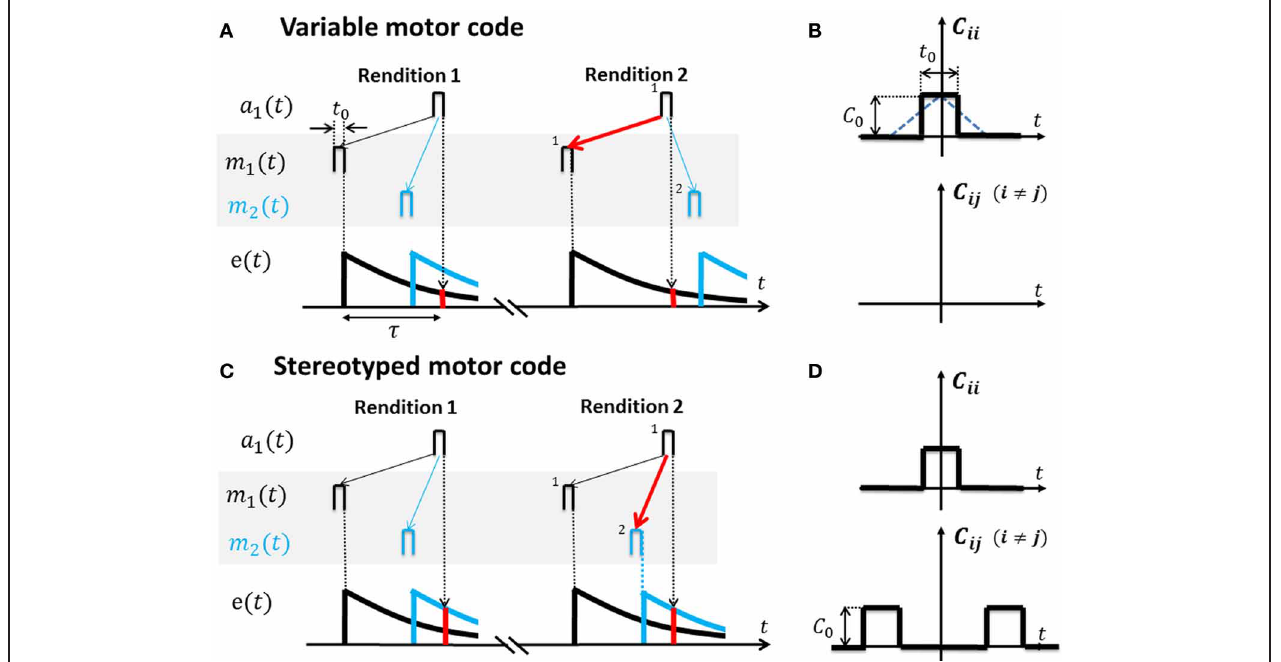
FIGURE 3 | Cross-correlation functions for variable and stereotyped motor codes. (A) In a variable motor code m ( t ) (shaded area). Activity bursts m 1 (black) and m 2 (blue) of width t 0 in two example motor neurons occur at diverse time lags relative to each other across renditions of the song motif. Auditory tuning in the shown sensory neuron is such that it responds a 1 to bursts m 1 after a time lag τ . Repeated co-activation m 1 → a 1 and non-zero eligibility e (τ) (red bar) at time lag τ leads to increased synaptic weight V 11 (red arrow) and to a causal inverse. Lack of correlation between m 2 and a 1 , as well as heterosynaptic competition, prevents V 21 from similarly increasing (blue thin arrow). (B) The cross-correlation function C ij ( t ) for variable codes is flat except the